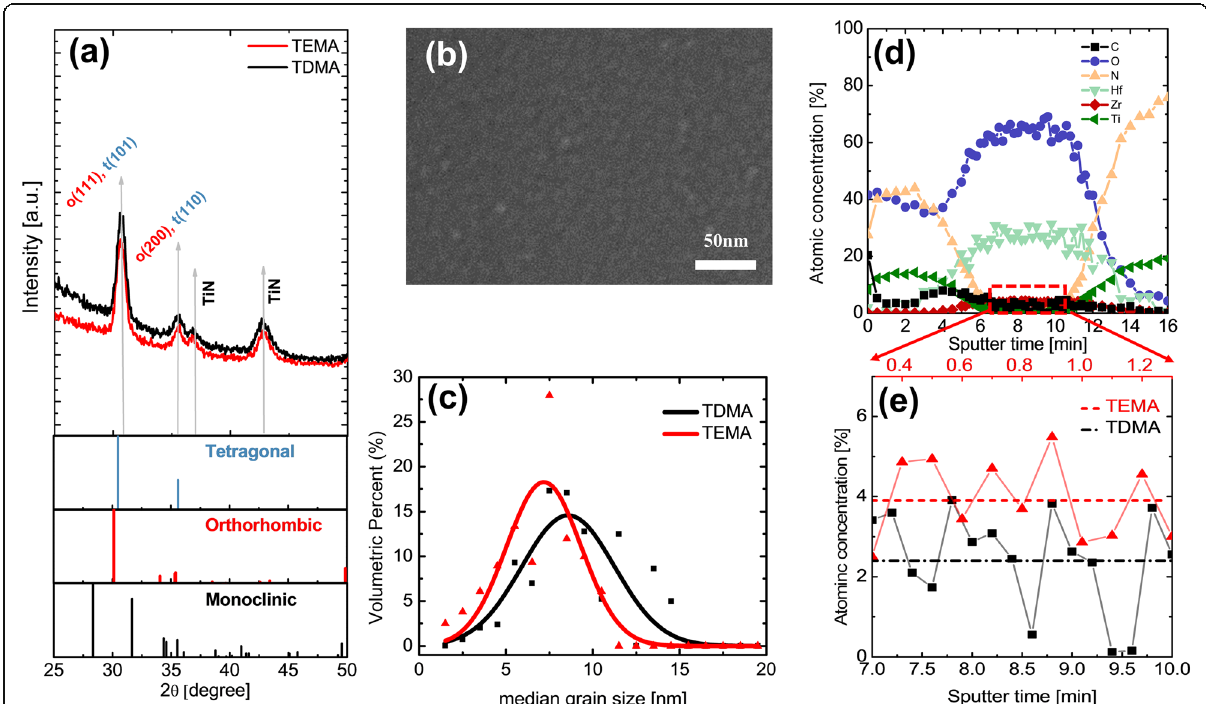
Fig. 1 (a) GIXRD patterns of HZO thin films deposited using TDMAH/TDMAZ (black curve) and TEMAH/TEMAZ (red curve), the reference patterns taken from literature for the monoclinic, tetragonal, and orthorhombic phases are attached in the bottom panels. ( b) The planar SEM image of TDMA HZO films and ( c) the grain size distribution of TEMA (red; reproduced from Ref. [15]), TDMA (black) HZO. ( d) The depth profile of the TDMA HZO thin films analyzed using time-of-flight Auger electron spectroscopy, and ( e) the enlarged low concentration region of the HZO film part. Average C concentration of TDMA (black dash-dot line), TEMA (red dash line; reproduced from Ref. [12]), HZO is